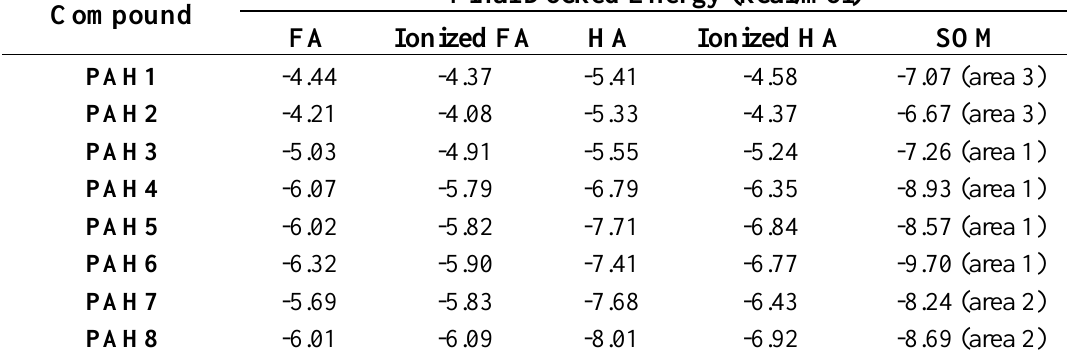
Docking of PAHs Final docked energies of the 18 PAHs are shown in Table 1. Table 1. Final docked energies of